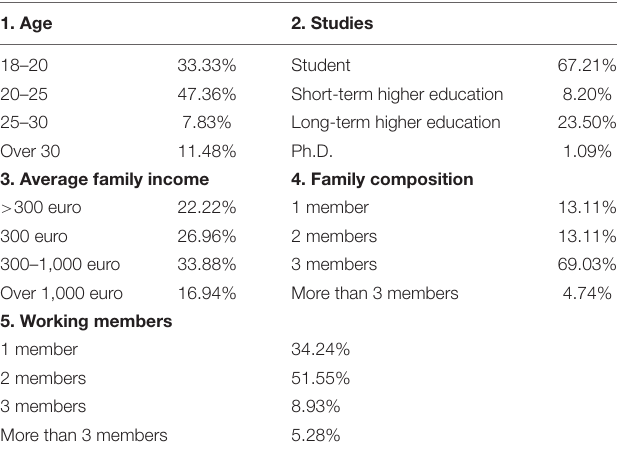
TABLE 3 | The structure of the respondents’ options on features related to age, degree of education, and other family